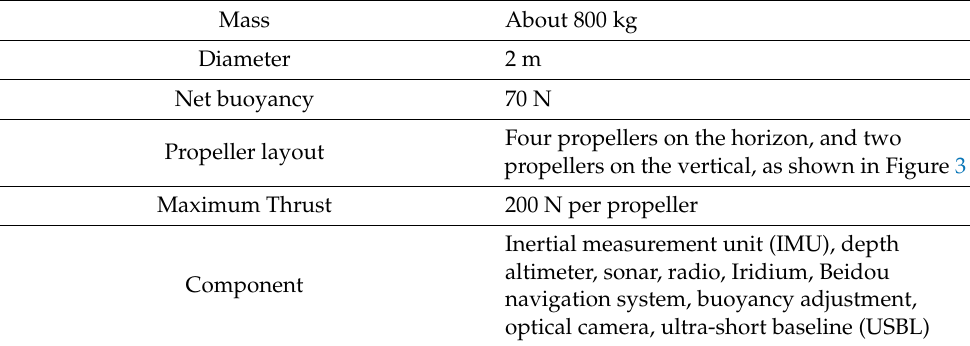
Table 1. The physical parameters and components of